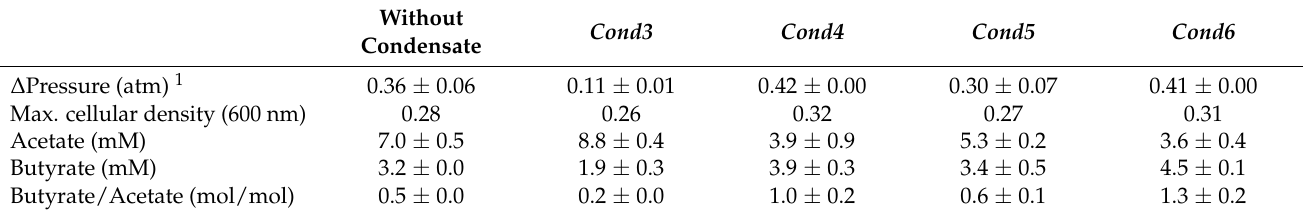
Table 7. Growth, acetate, and butyrate production by B. methylotrophicum during syngas fermentation in the presence or absence of 1:1000 vol. of Cond3 to Cond6